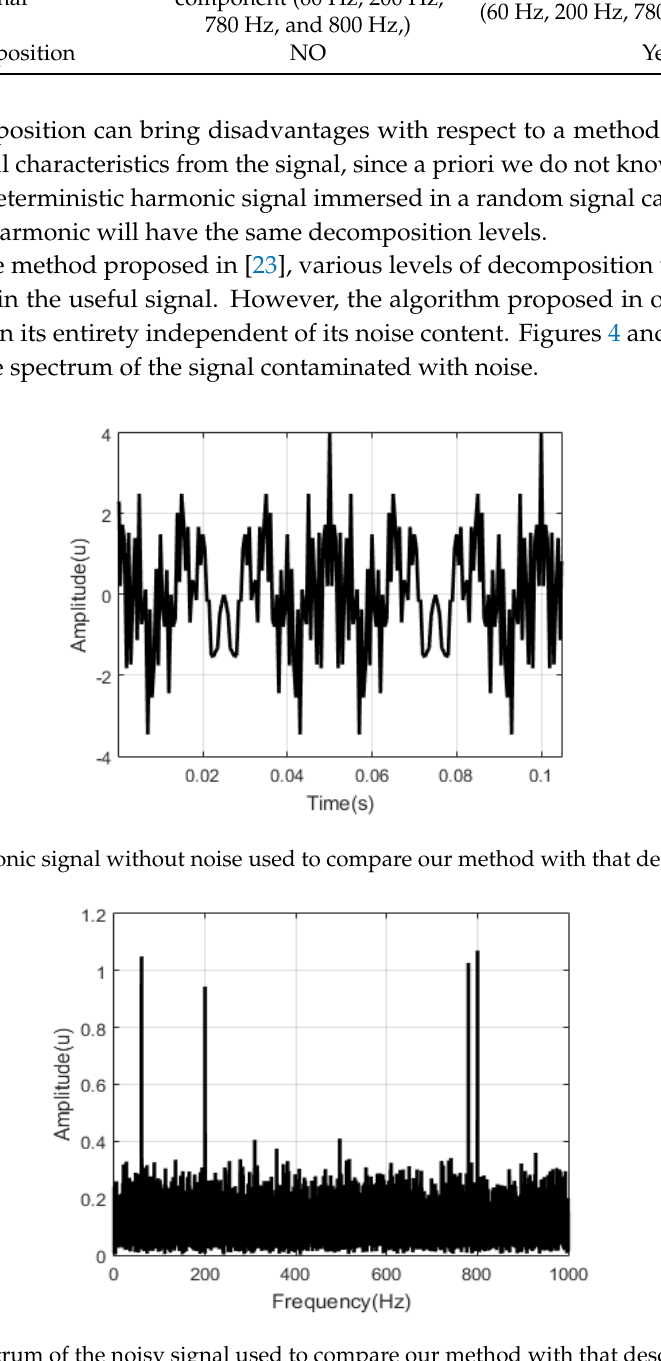
Figure 5. Spectrum of the noisy signal used to compare our method with that described in [5].